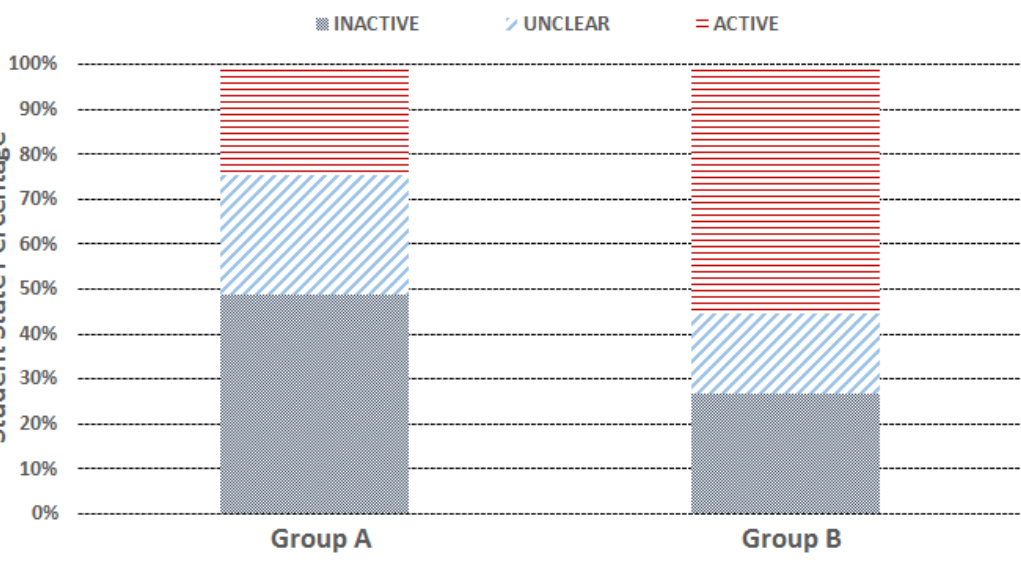
Figure 11. Distribution of student state duration